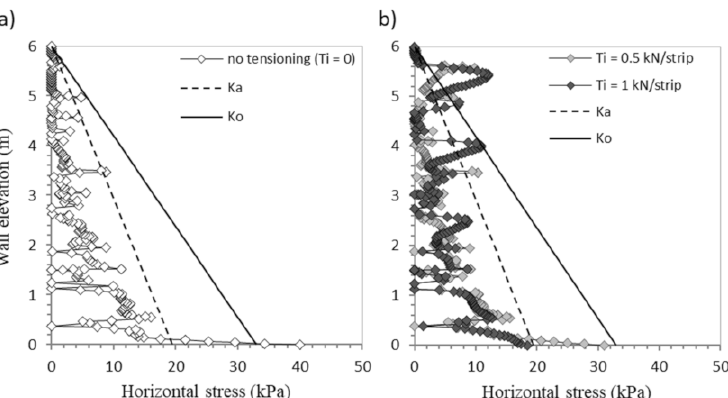
Figure 20. Horizontal earth pressure at the facing for the D i = 0.6 H case at the end of construction (EoC): ( a ) no tension case and ( b ) different pre-tensioning loads.